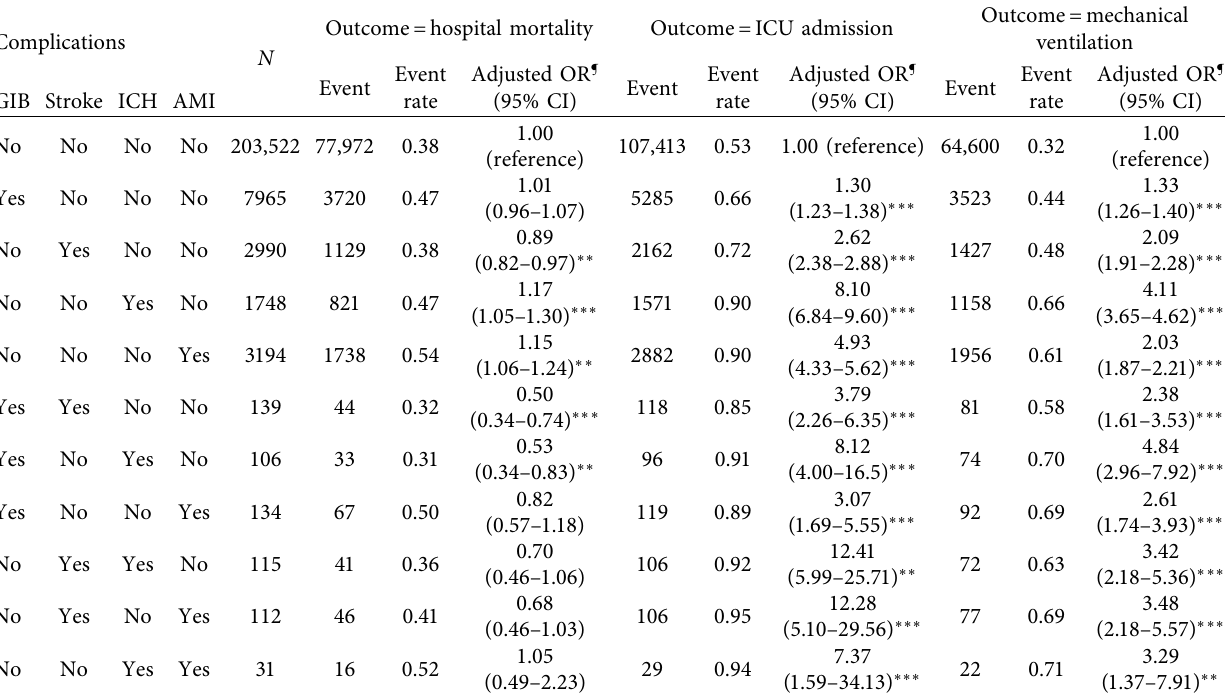
Table 3: Joint effect analyses of association between “hospital mortality, ICU admission, and receiving mechanical ventilation” and “GI bleeding, stroke, ICH, and